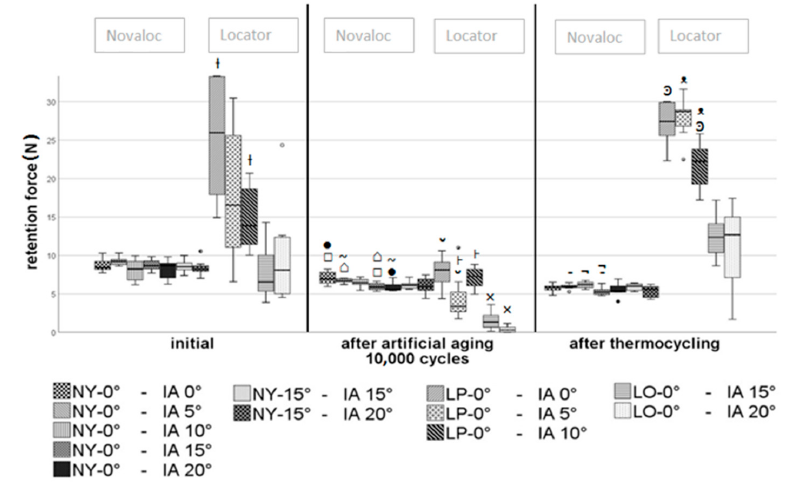
Figure 7. Median values as a function of implant angulation; for labeling, refer to Table 1. Significances: □ p = 0.006, ● p = 0.007, ⌂ p = 0.002, ~ p = 0.004; - p = 0.015, ¬ p = 0.003; × p = 0.031;